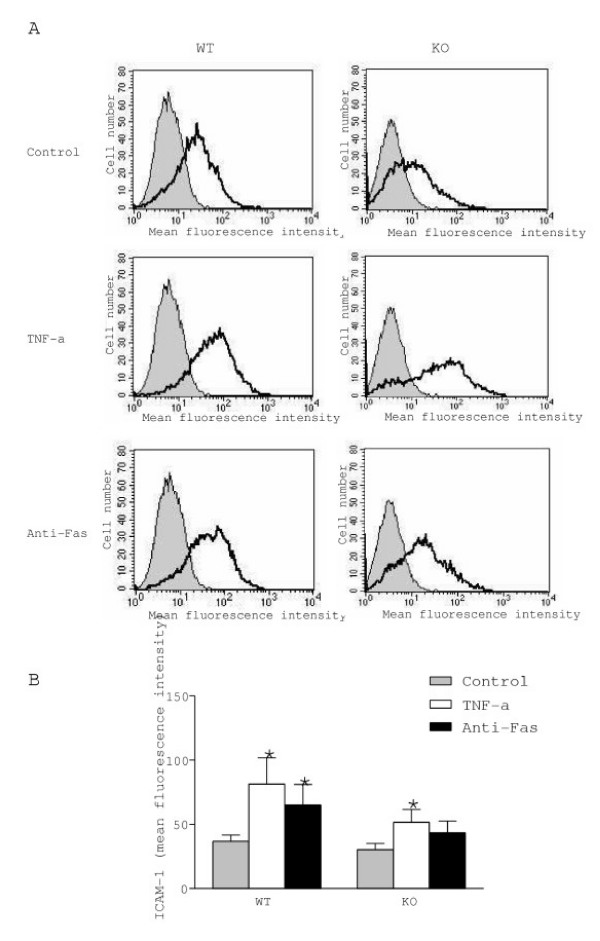
Expression of ICAM-1 in WT and KO astrocytes. A. Plots of flow cytometry after treatment with TNF-α or anti-Fas antibody. B. Quantification of ICAM-1 expression. ICAM-1 levels were up-regulated by TNF-α in astrocytes from WT and KO mice, whereas Fas activation increased ICAM-1 expression only in WT astrocytes. Values represent the mean +/- s.e.m. of at least three independent experiments. Statistical differences were determined by Student's t-test when comparing treatments to control cells (* p < 0.05).